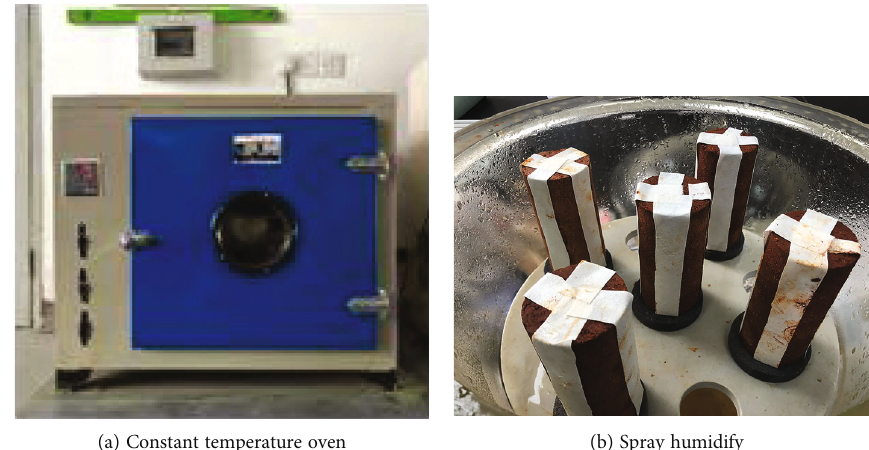
Figure 4: The drying process and wetting process.